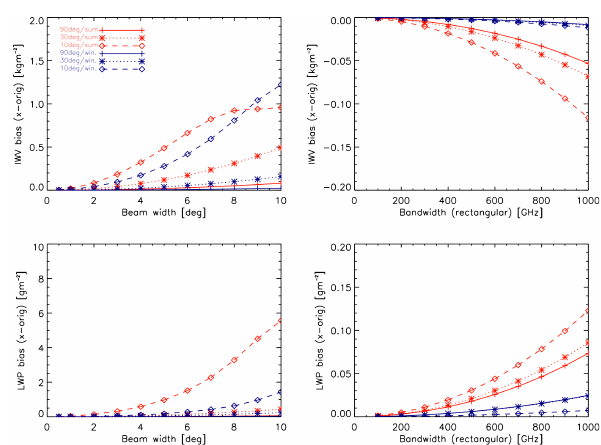
Fig. 6. The error in the retrieved IWV (in kgm − 2 ) and LWP (in gm − 2 ) zenith corrected caused by the errors in TB by not taking Figure 6. The error in the retrieved IWV (in kg/m 2 ) and LWP (in g/m 2 ) zenith corrected caused 5 into account antenna beam width (right) or bandwidth (left). The errors are shown for both the mid-latitude summer (red) and the by the errors in TB by not taking into account antenna beam width (right) or bandwidth (left). 6 mid-latitude winter soundings (blue) for elevation angles 10 ◦ (dash The errors are shown for both the mid-latitude summer (red) and the mid-latitude winter 7 square), 30 ◦ (dot star), and 90 ◦ (line + soundings (blue) for elevation angles 10° (dash square), 30° ( dot star), and 90° (line +). 8